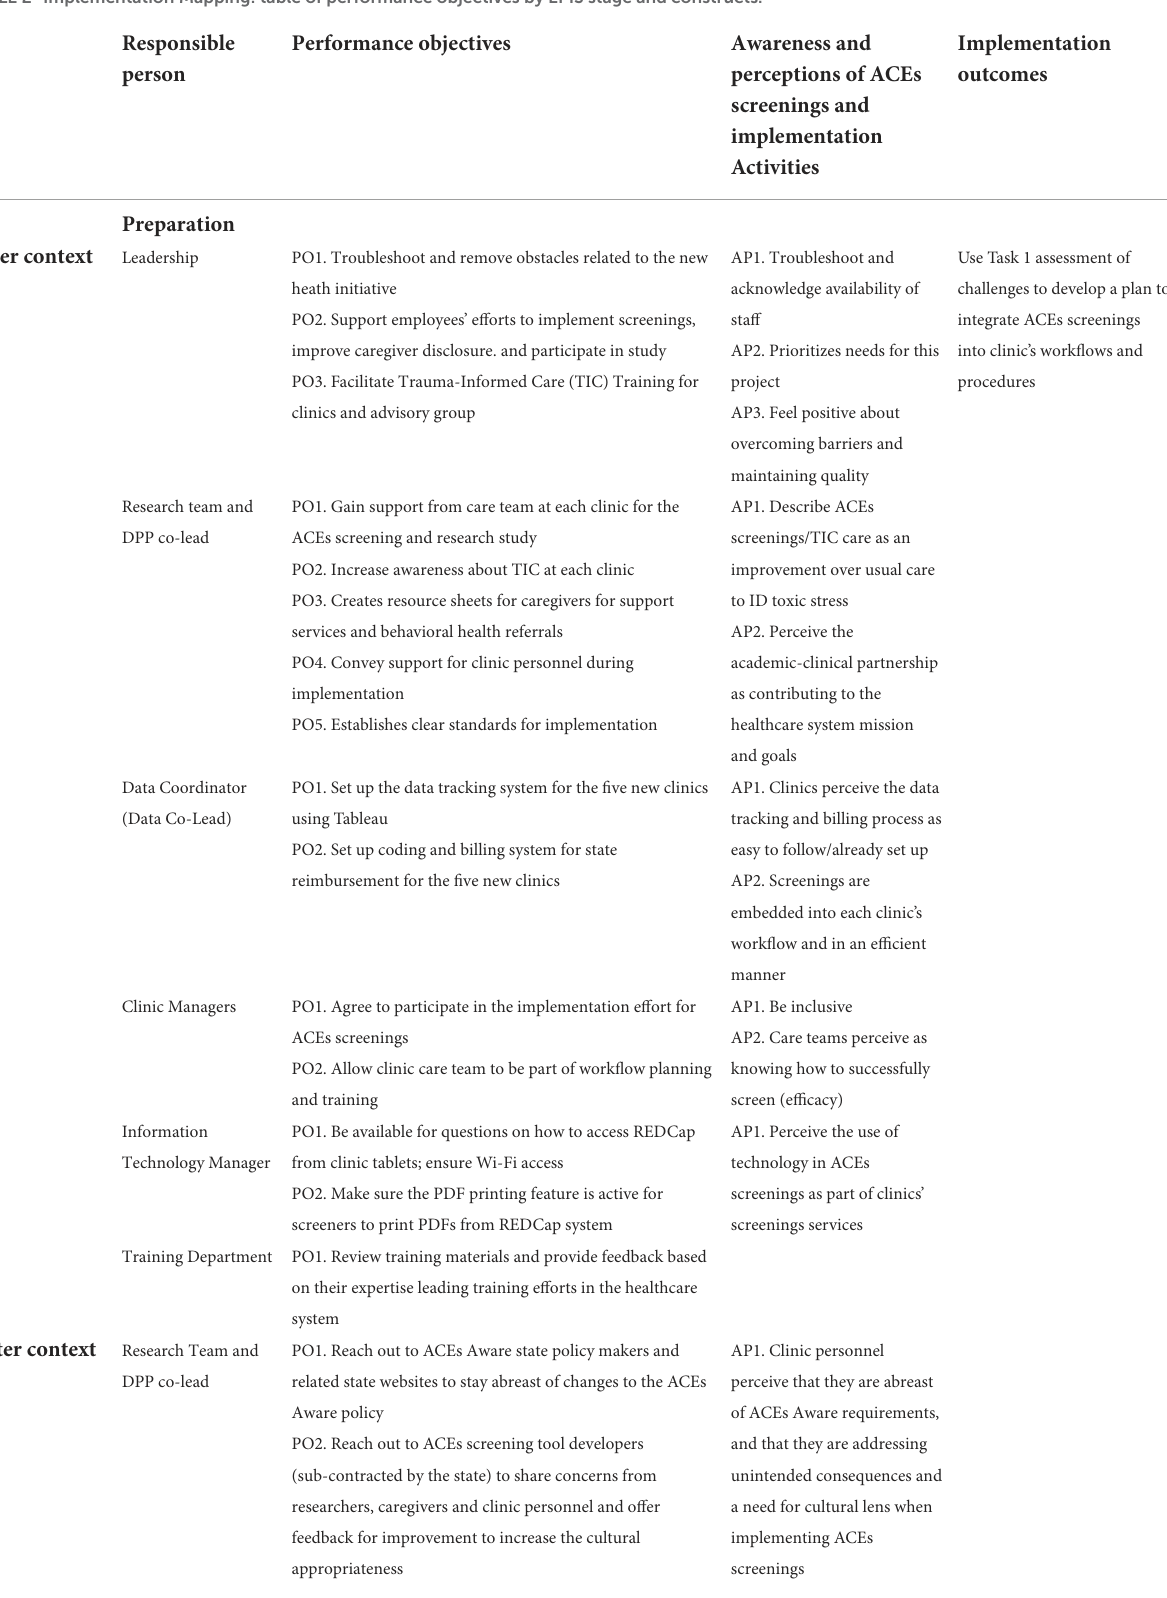
TABLE 2 Implementation Mapping: table of performance objectives by EPIS stage and